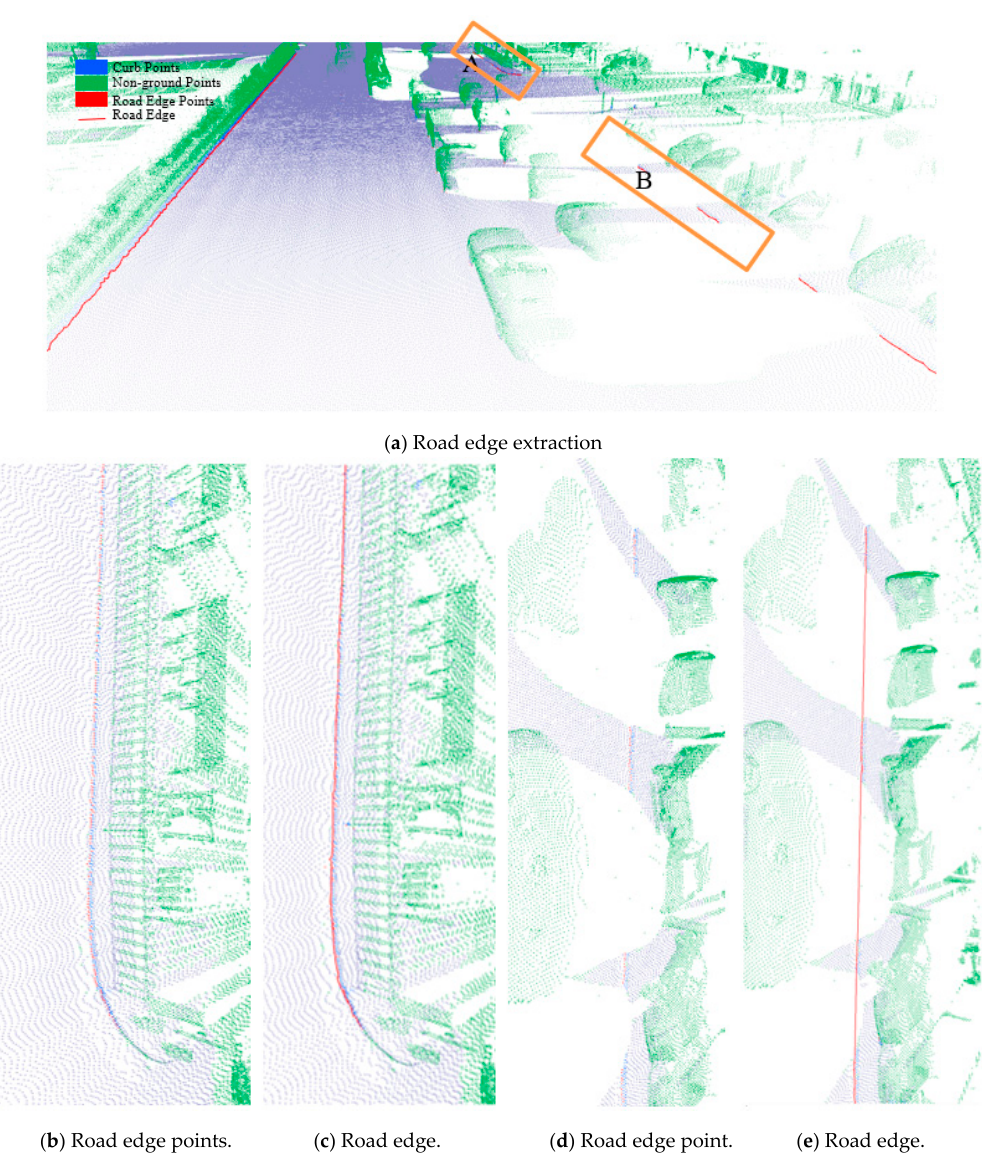
Figure 7. Extracted road edges for a structural road. ( b ) and ( d ) are the close-up view of region A and B in ( a ), respectively; and ( b ) and ( d ) show the road edge points extracted based on our proposed method; ( c ) and ( e ) are the road edge of ( b ) and ( c ), respectively.